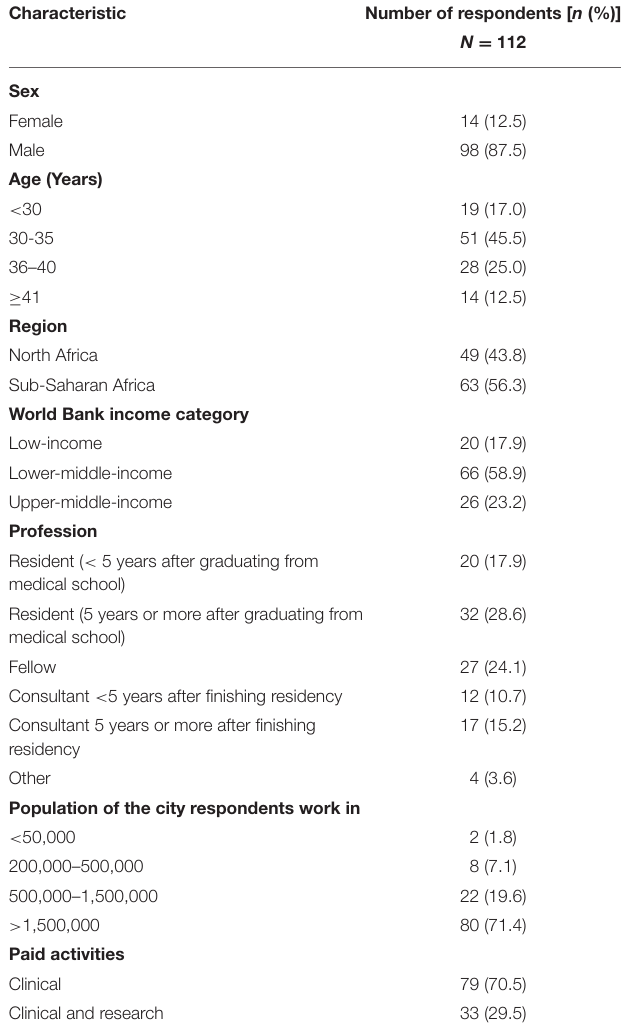
TABLE 1 | Descriptive characteristics of the survey respondents and their